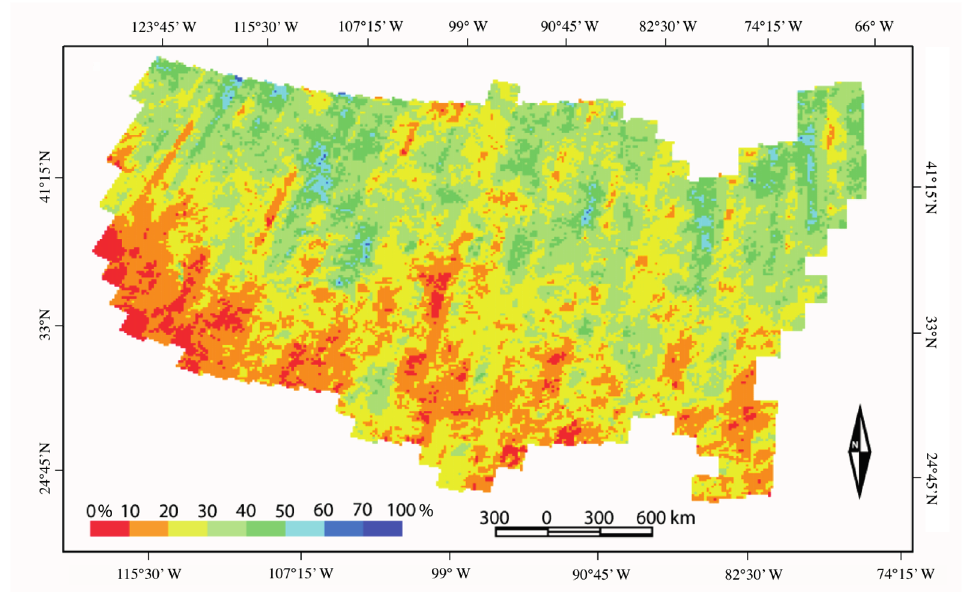
Figure 3. Percentage of high confidence cirrus detections over 53 weeks of Landsat 8 observations derived at each 30 m conterminous US Albers projection pixel location. For visualization purposes the median percentages in 43,593 non-overlapping 15 × 15 km gridcells are shown. Results shown using the same color map as Figure